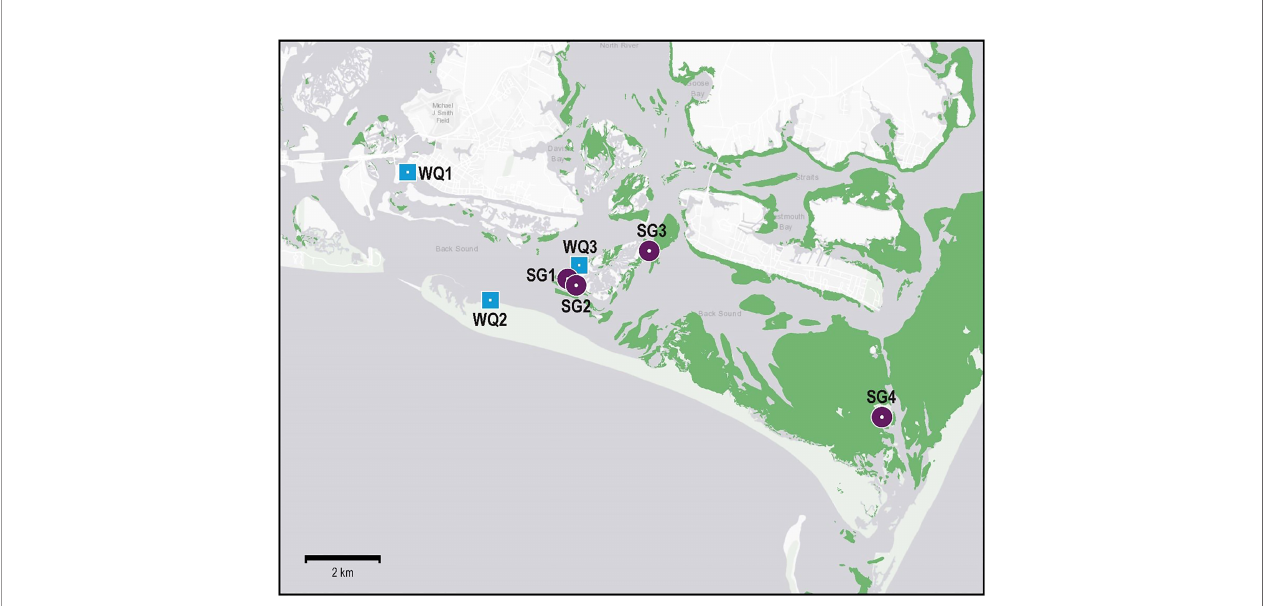
FIGURE 2 | Map of all seagrass (SG) and water quality (WQ) sampling locations used in this study. See ( Tables 1 , 2 ) for information on sources of data, sampling frequency, and types of data collected. Green areas denote known historical extent of seagrass throughout the polyhaline region of coastal North Carolina from 1981-2019 (data from NC Division of Marine